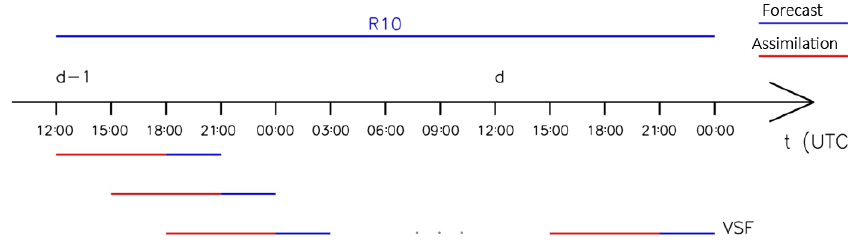
Figure 12. The implementation of RAMS@ISAC very short-term forecast.